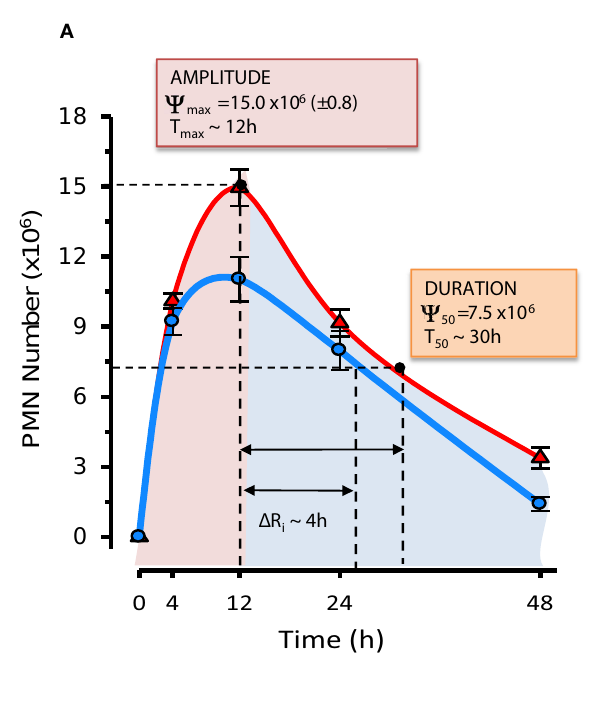
significantly lowers amplitude (i.e., Ψ max ) and duration ( T 50 ) of PMN infiltration, shortening the R i by ∼ 4h. (B) Heat map cluster represents relative expression of ∼ 300 mouse miRNAs from resolving exudates determined with real-time PCR after normalization with housekeeping small RNAs (snoRNA251, snoRNA202, snoRNA142, and Rnu6). Relative expression intensities are indicated in a green-red color code based on ∆ Ct expression values ( n = 3 mice/group).Temporal and RvD1-regulated miRNAs are